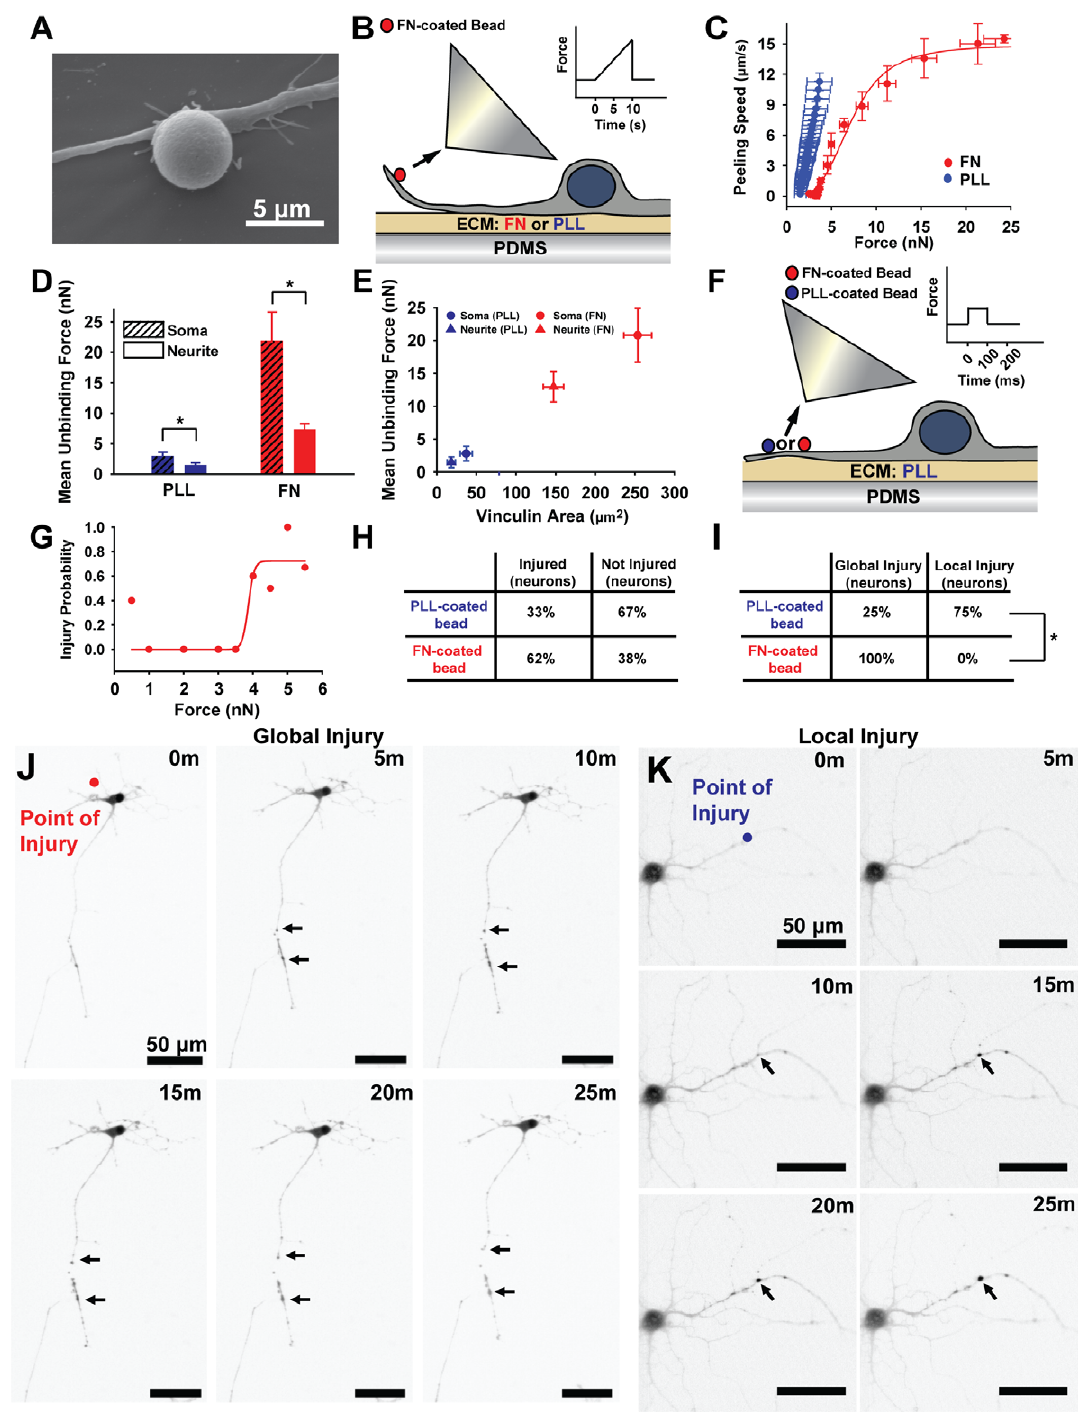
Figure 3. Role of integrins in adhesion strengthening and injury. ( A ) Paramagnetic beads, as shown by SEM, were bound to neurons. ( B ) The failure strength of neuron/substrate adhesions was measured using either FN-coated (red) or PLL-coated (blue) substrates. The beads were pulled with an ascending ramp in force as indicated by the inset. ( C ) The speed at which neurons detached from the substrate (Peeling Speed) during the ascending pull was plotted as a function of the applied force for PLL-coated (blue) and FN-coated substrates (red) ( n $ 4). ( D ) The maximum force required for complete detachment (Mean Unbinding Force) for soma (dashed) and neurite (plain) was plotted for PLL-coated substrates (blue) and FN-coated substrates (red) ( n $ 4). ( E ) Mean unbinding forces for the soma (circles) and neurites (triangles) of cells on PLL or FN coated substrates was plotted as a function of mean vinculin area ( n $ 4). ( F ) Magnetic Tweezers were used to deliver a 100 ms pulse (inset) to neurons with either FN (red) or PLL (blue) coated beads. ( G ) FN-coated beads were used to establish an injury dose response curve. ( H ) FN-coated beads were able to injure cells more often than PLL-coated beads and the extent of injury (I) depended upon bead coating. ( J ) FN-coated beads always caused global cellular injury (focal swellings indicated by black arrows extended throughout the cell), while ( K ) PLL-coated beads tended to injure locally to the bead-pull site ( n =13 for FN-coated beads and n =12 for PLL-coated beads). Inverted fluorescence images from neurons loaded with Fluo-4 calcium dye. All bars SEM for all panels, * p , 0.05. doi:10.1371/journal.pone.0022899.g003 PLoS ONE |